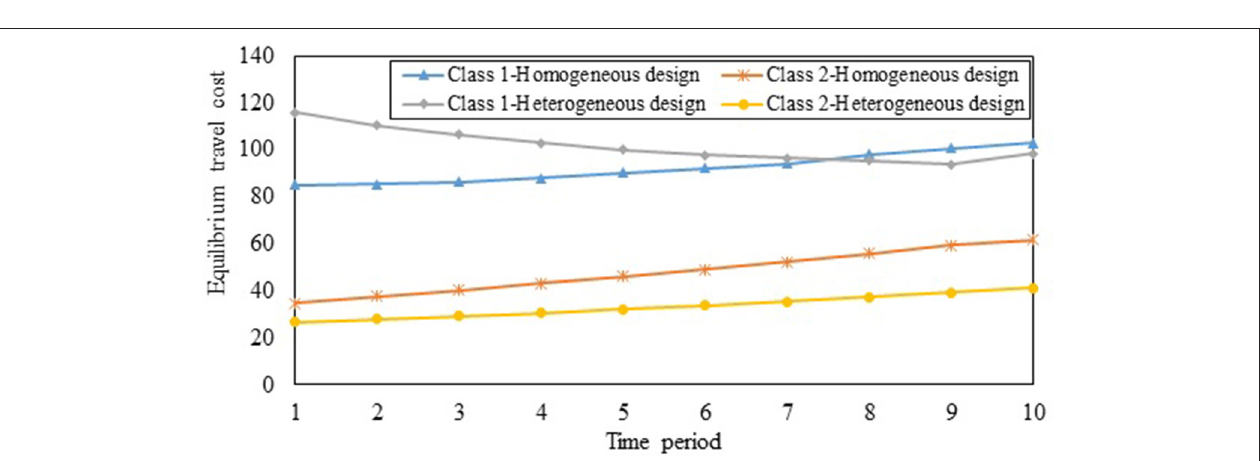
Frontiers in Built Environment |